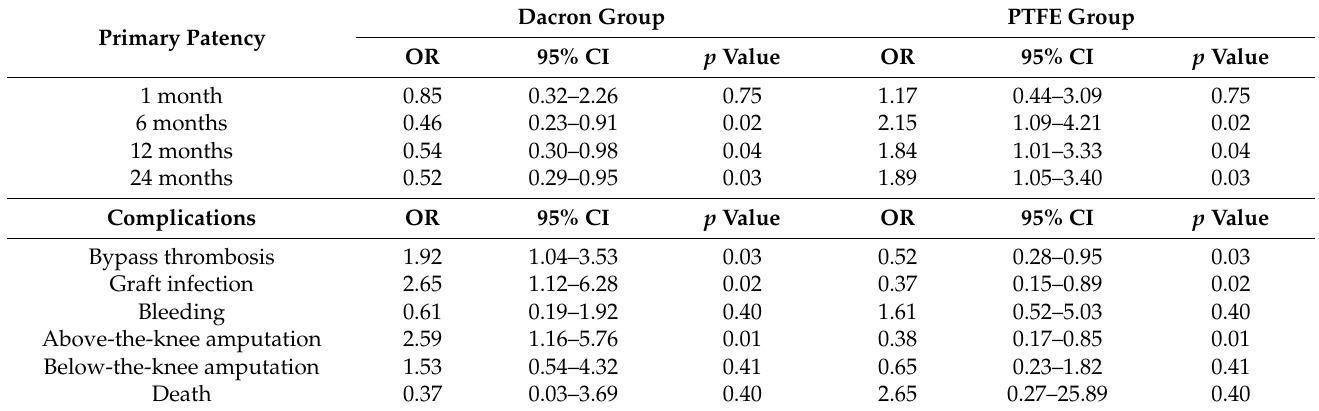
Table 6. Multivariate analysis regarding the type of graft and all outcomes.